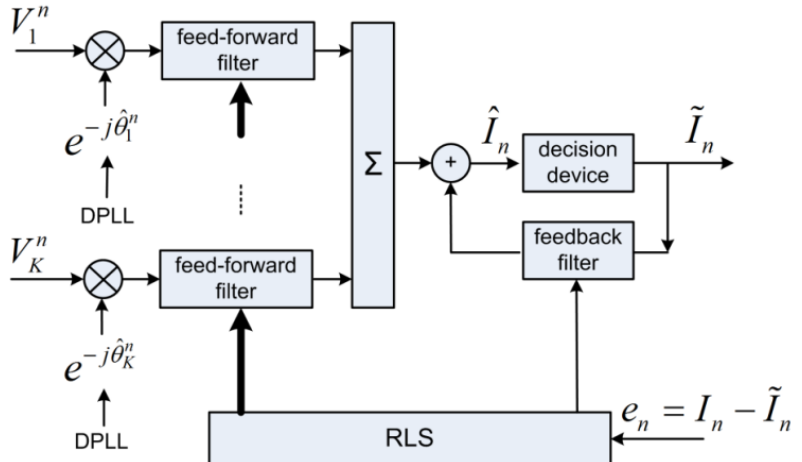
 at the k th receiving channel, ˆ k